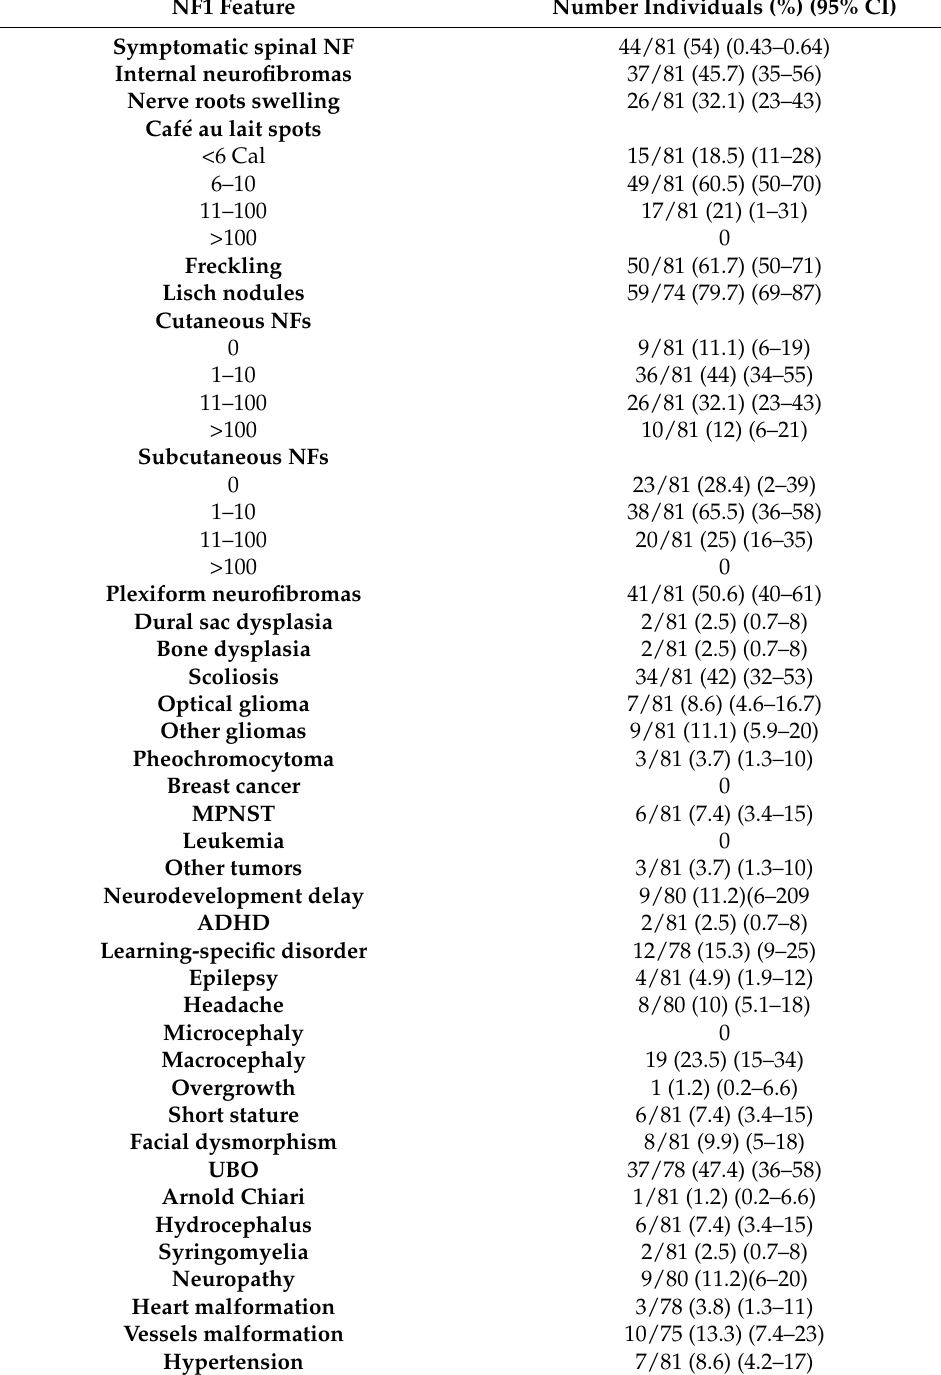
Table 1. SNF patients’ clinical